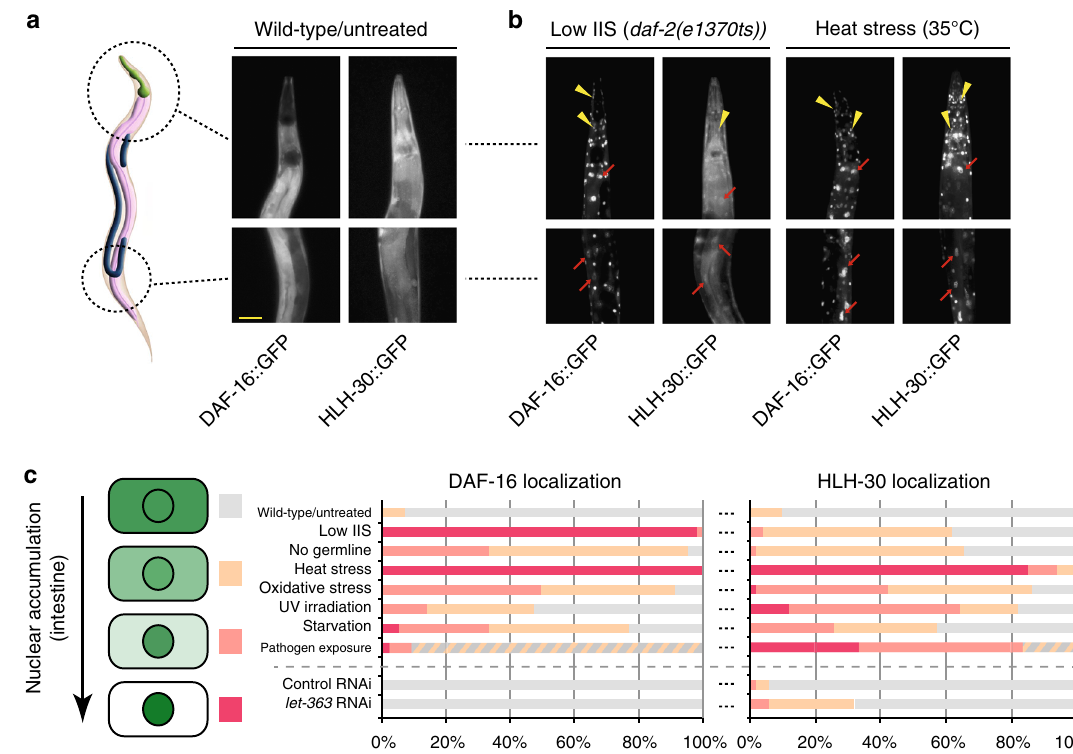
Fig. 2 DAF-16/FOXO and HLH-30/TFEB are globally expressed and translocate to the nucleus under harmful conditions. a DAF-16 and HLH-30 are co- expressed in most tissues of the animal. GFP signal in young adults of the indicated strains is shown. Yellow scale bar: 40 µ m. (The anatomical sketch was adapted from wormatlas.org.) b , c DAF-16 and HLH-30 both translocate into the nucleus upon dire conditions. In b , GFP signal in young adults of the indicated strains under low insulin/IGF signaling (IIS, daf-2(e1370ts ) for 12 h at 25 °C) or heat stress (1 h at 35 °C) is shown. Yellow arrowheads indicate examples of neuronal and red arrows examples of intestinal nuclear translocation events. In c , nuclear translocation of DAF-16 or HLH-30 in day 2 adult animals was scored using DAF-16::GFP or HLH-30::GFP expressing strains under the following stresses and lifespan extending conditions: wild type/ untreated, low IIS ( daf-2(e1370ts) , 12 h at 25 °C), no germline ( glp-1(e2141ts) , grown from L1 at 25 °C), heat stress (1 h at 35 °C), oxidative stress (12 h on 100 mM tBOOH), UV irradiation (360 mJ cm − 2 followed by 45 min of recovery), starvation (6 h without food), pathogen exposure (1 day of growth on Pseudomonas araginosa ; here the categories of no nuclear enrichment (gray) and weak nuclear enrichment (light orange) are combined, since the high background fl uorescence of the pathogenic media made distinction of these categories impossible), and reduced TOR signaling (RNAi against let-363 from the L4 stage). ( n =